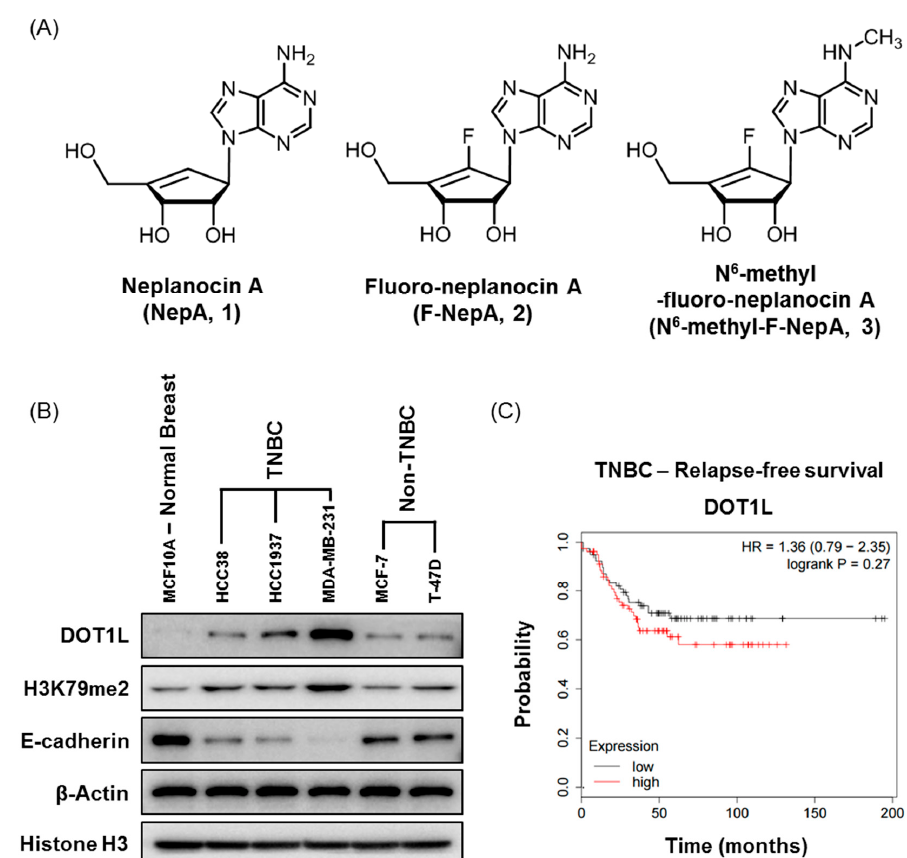
Figure 1. DOT1L expression levels in BCs and correlation between DOT1L expression and relapse-free survival in patients with TNBC. ( A ) Structures of NepA analogs: NepA, 1 ; F-NepA, 2 ; N 6 -methyl-F-NepA, 3 . ( B ) DOT1L, H3K79me2, and E-cadherin levels in various BC cell lines were detected by Western blotting. β -Actin and Histone H3 were used as an internal control. ( C ) The Kaplan–Meier survival curve represents the relapse-free survival durations of patients with TNBC according to the DOT1L (Affy ID: 226201_at) expression level. Table 1. Antiproliferative activities of NepA analogs against a panel of human BC cell lines.